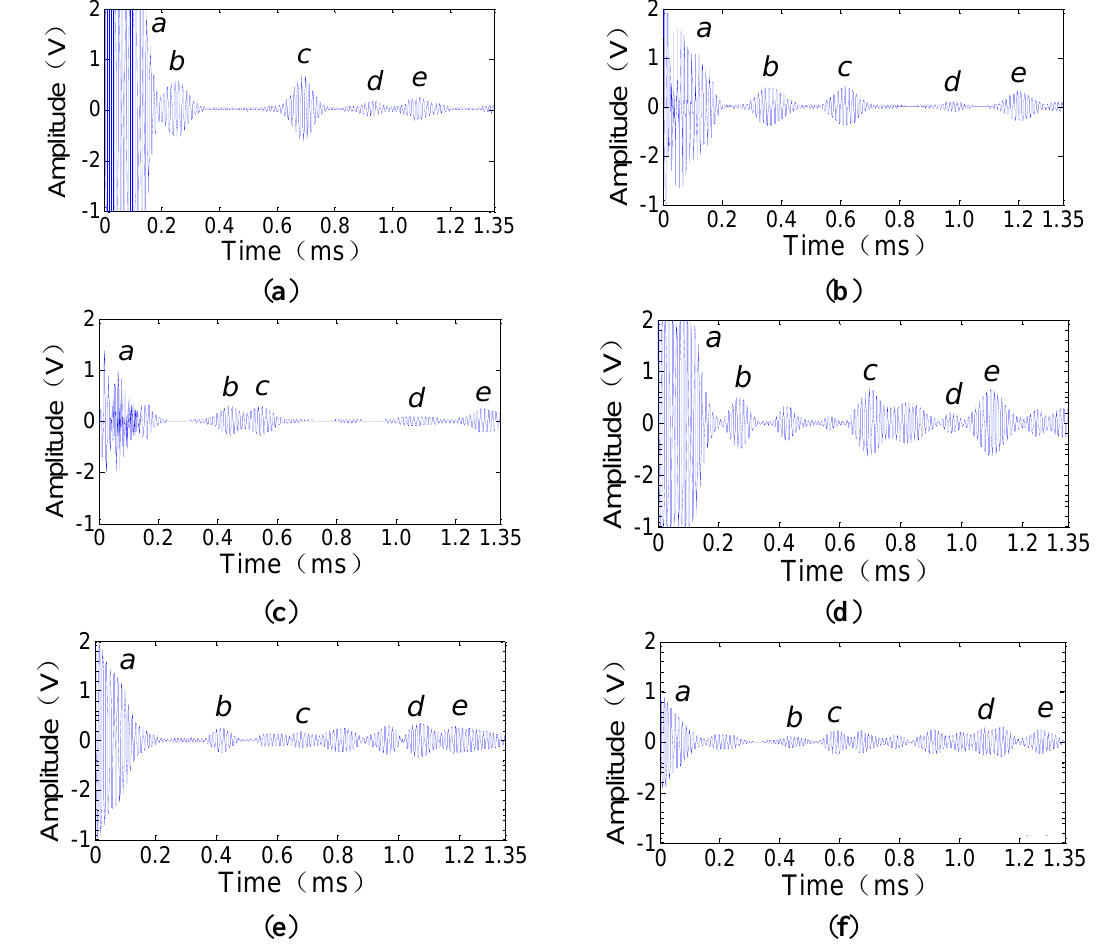
Figure 6. Detected waveforms of the A0 mode ULW transmitting and receiving experiments. ( a ) Using the new CFC EMATs, the receiver at position 1; ( b ) Using the new CFC EMATs, the receiver at position 2; ( c ) Using the new CFC EMATs, the receiver at position 3; ( d ) Using the traditional CWSC EMATs, the receiver at position 1; ( e ) Using the traditional CWSC EMATs, the receiver at position 2; ( f ) Using the traditional CWSC EMATs, the receiver at position